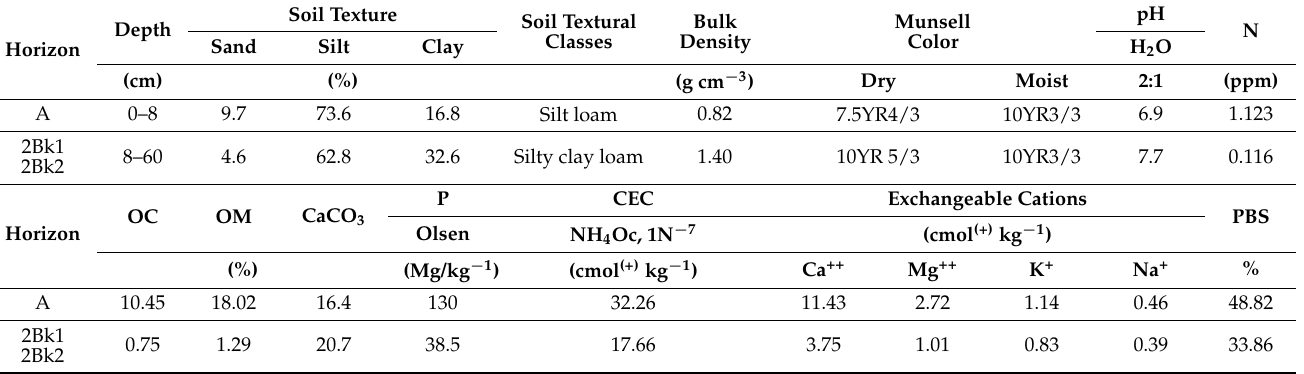
Figure 5. Natural soil profile under Prosopis glandulosa vegetation. Table 2. Soil natural profile